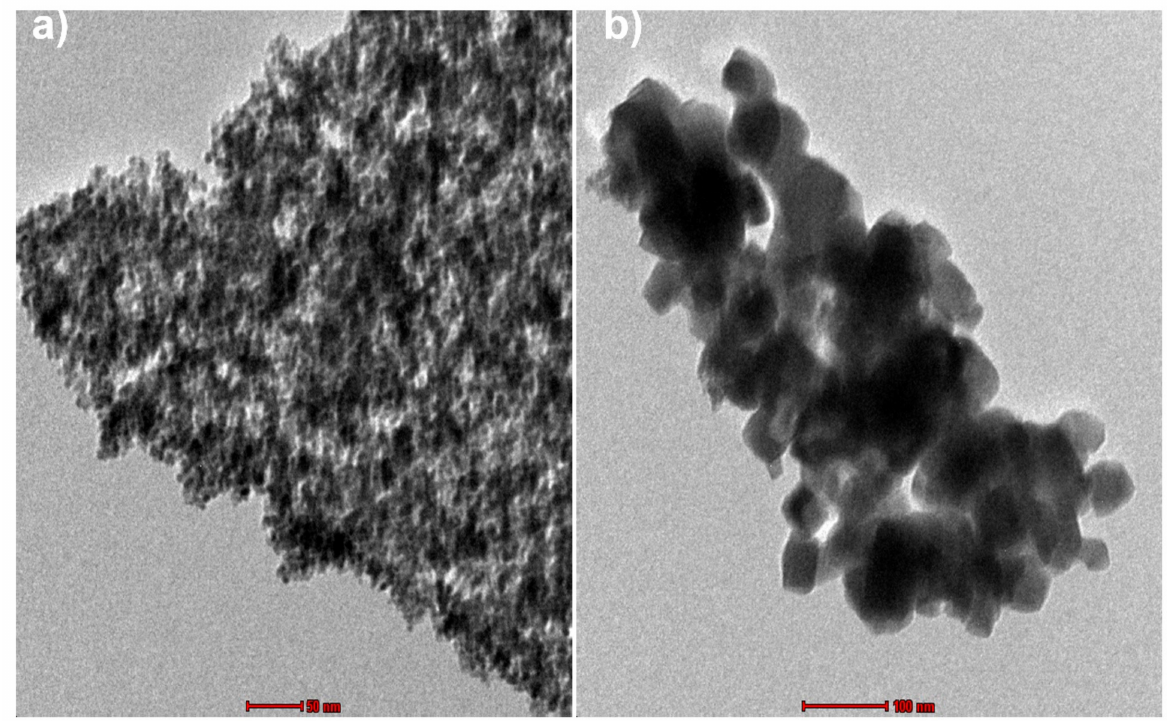
Figure 7. ( a , b ) TEM images of synthesized FNH